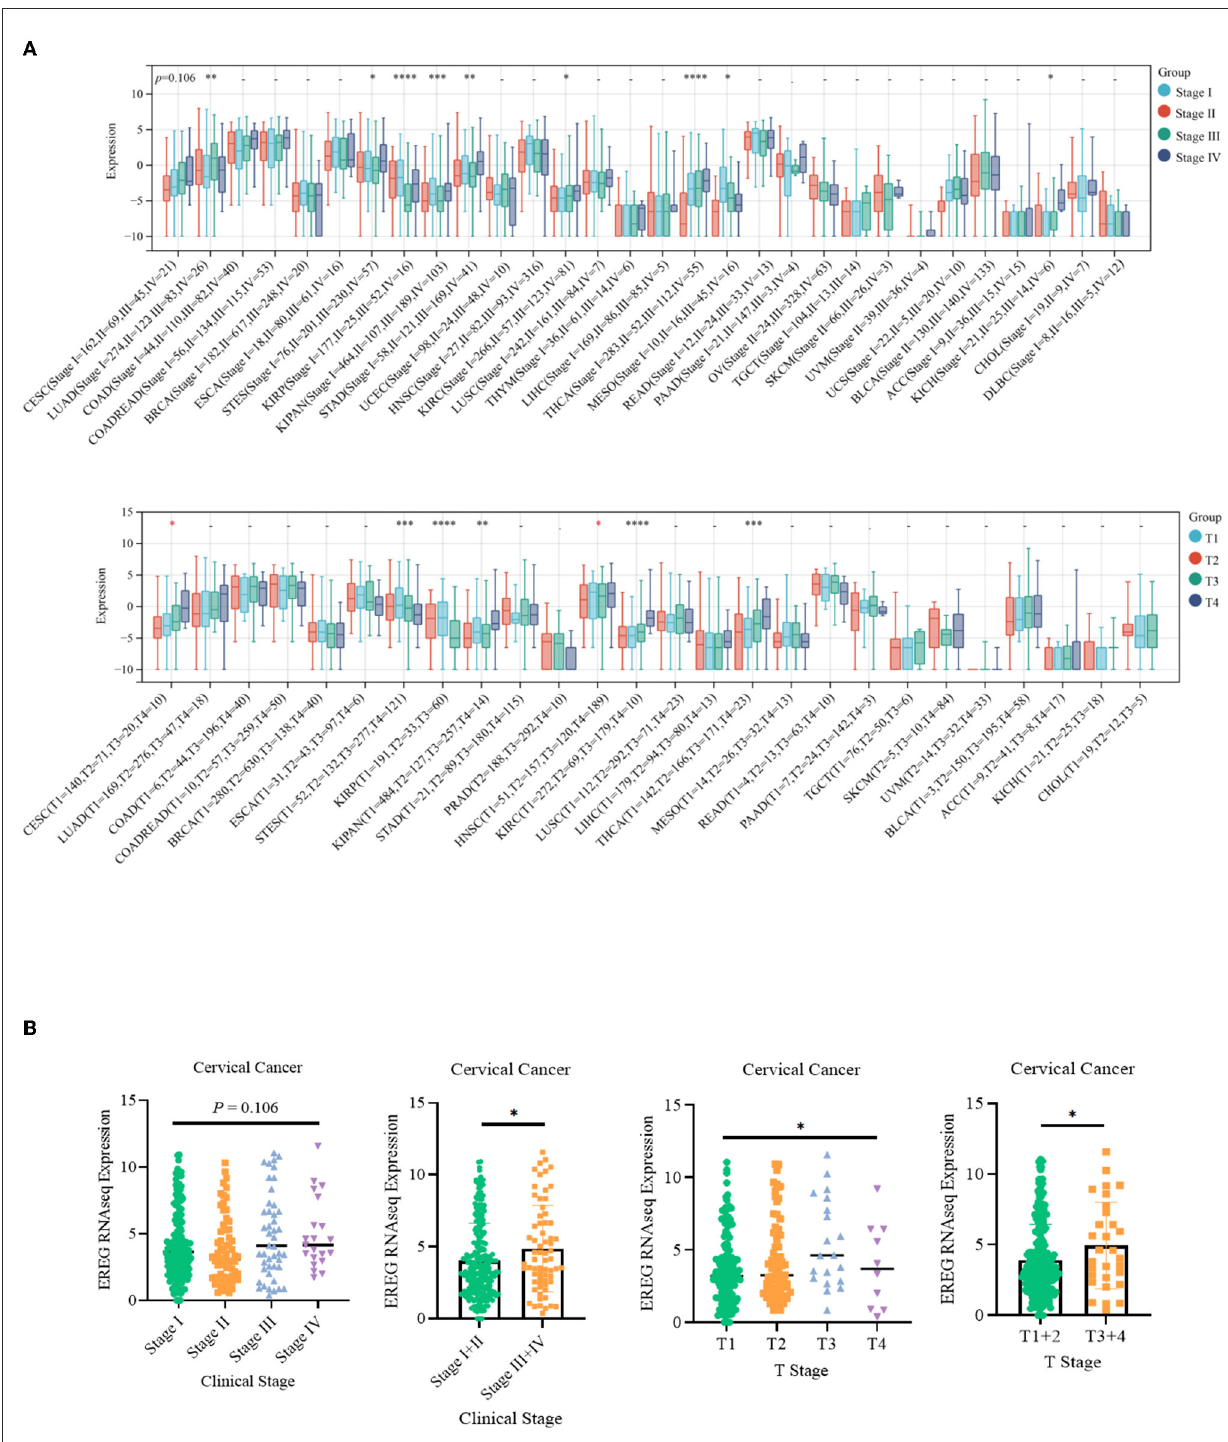
FIGURE2 Clinical feature analysis of EREG in Pan-Cancer and patients with cervical cancer. (A) The relationship between EREG expression and clinical features (clinical stage and T stage) in Pan-Cancer. (B) The relationship between EREG expression and clinical features in cervical cancer. “*” represented p < 0.05, indicated statistically